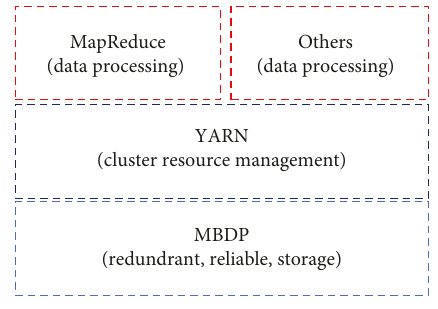
Figure 1: The core of the medical big data